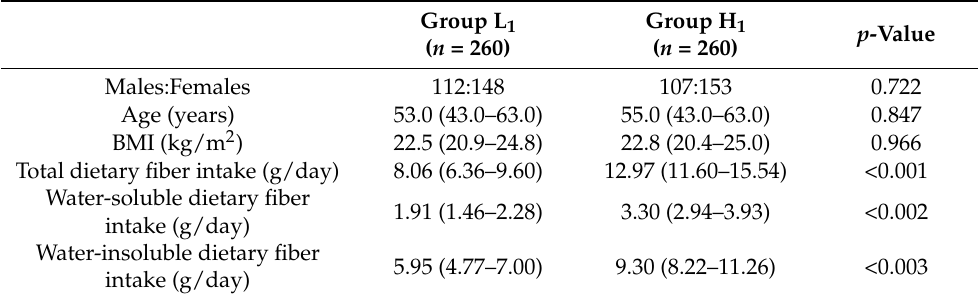
Table 2. Participants’ characteristics after matching for sex, age, and BMI.